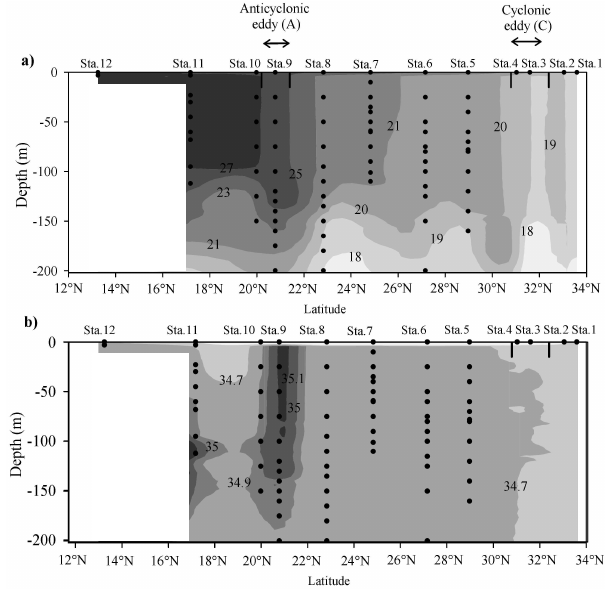
Fig. 4. Vertical distributions of temperature (a) and salinity (b) mea- sured along the studied transect (141.5 ◦ E). The location of the ob- served stations is indicated in the upper scale axis. Black dots illus- trate the sampling depths. Cold core cyclonic eddy (C) and warm core anticyclonic eddy (A) identified with the sea level anomaly map are shown with small black